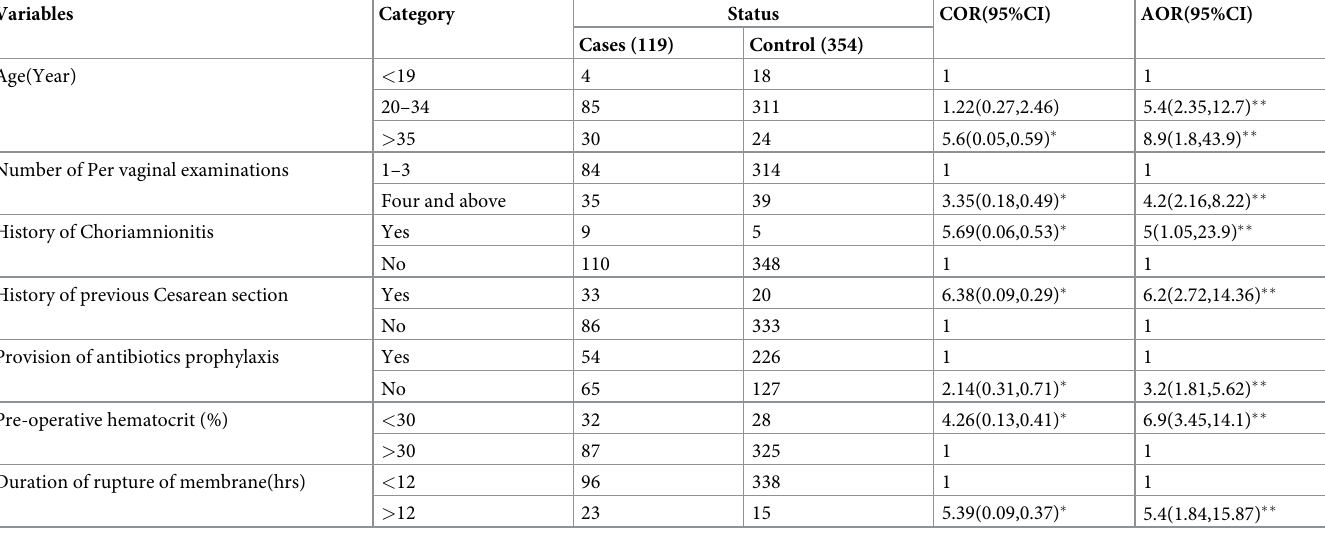
Table 3. Factors associated with post cesarean section surgical site infection at Dire Dawa administration public hospitals,